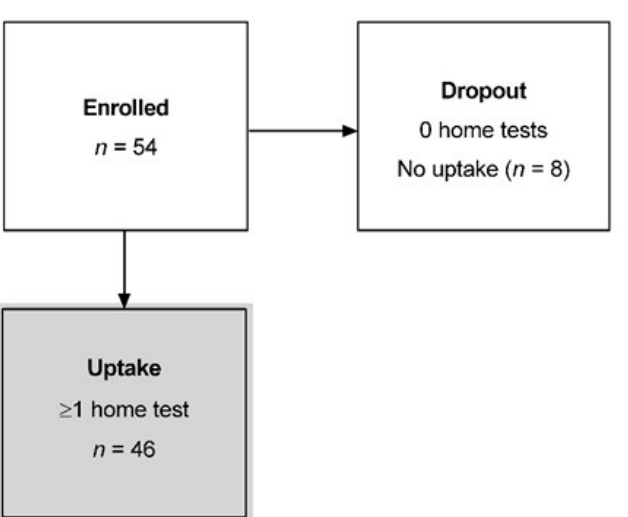
Figure 3. CONSORT diagram for the long-term Melbourne Rapid Fields home (MRFh) study. n = 54. Shaded box indicates the number of participants with uptake.